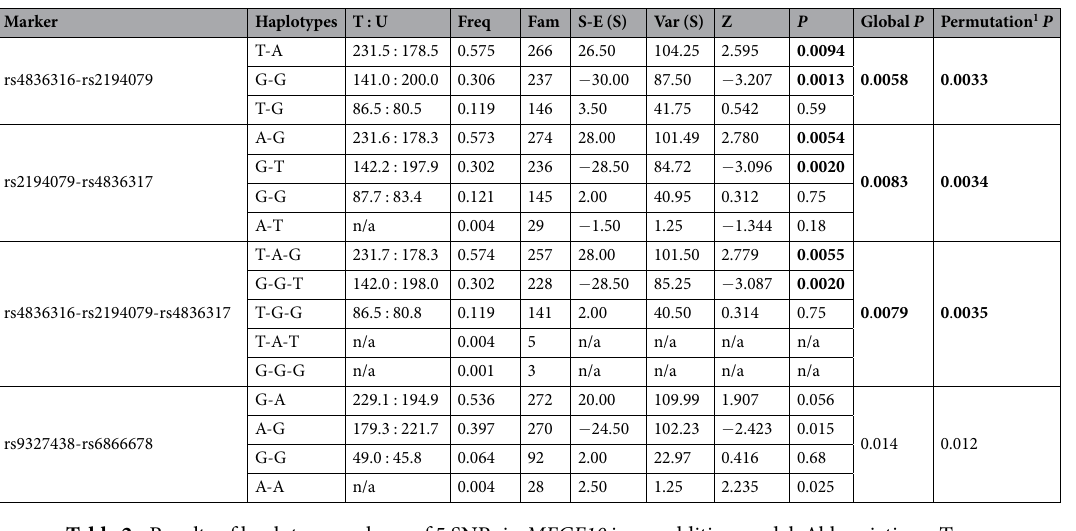
Table 2. Results of haplotype analyses of 5 SNPs in MEGF10 in an additive model. Abbreviations: T, transmitted; U, untransmitted; Freq, Estimation of haplotype frequencies; Fam, number of informative families; S, test statistics for the observed number of transmitted alleles; E(S), expected value of S under the null hypothesis (i.e., no linkage and no association); n/a: not applicable. Note: 1 The number of permutation is 10,000; whole marker permutation test using chisq sum p value; T : U is the ratio of transmissions to non transmissions of the allele; P value in bold font represents statistical significance after permutation